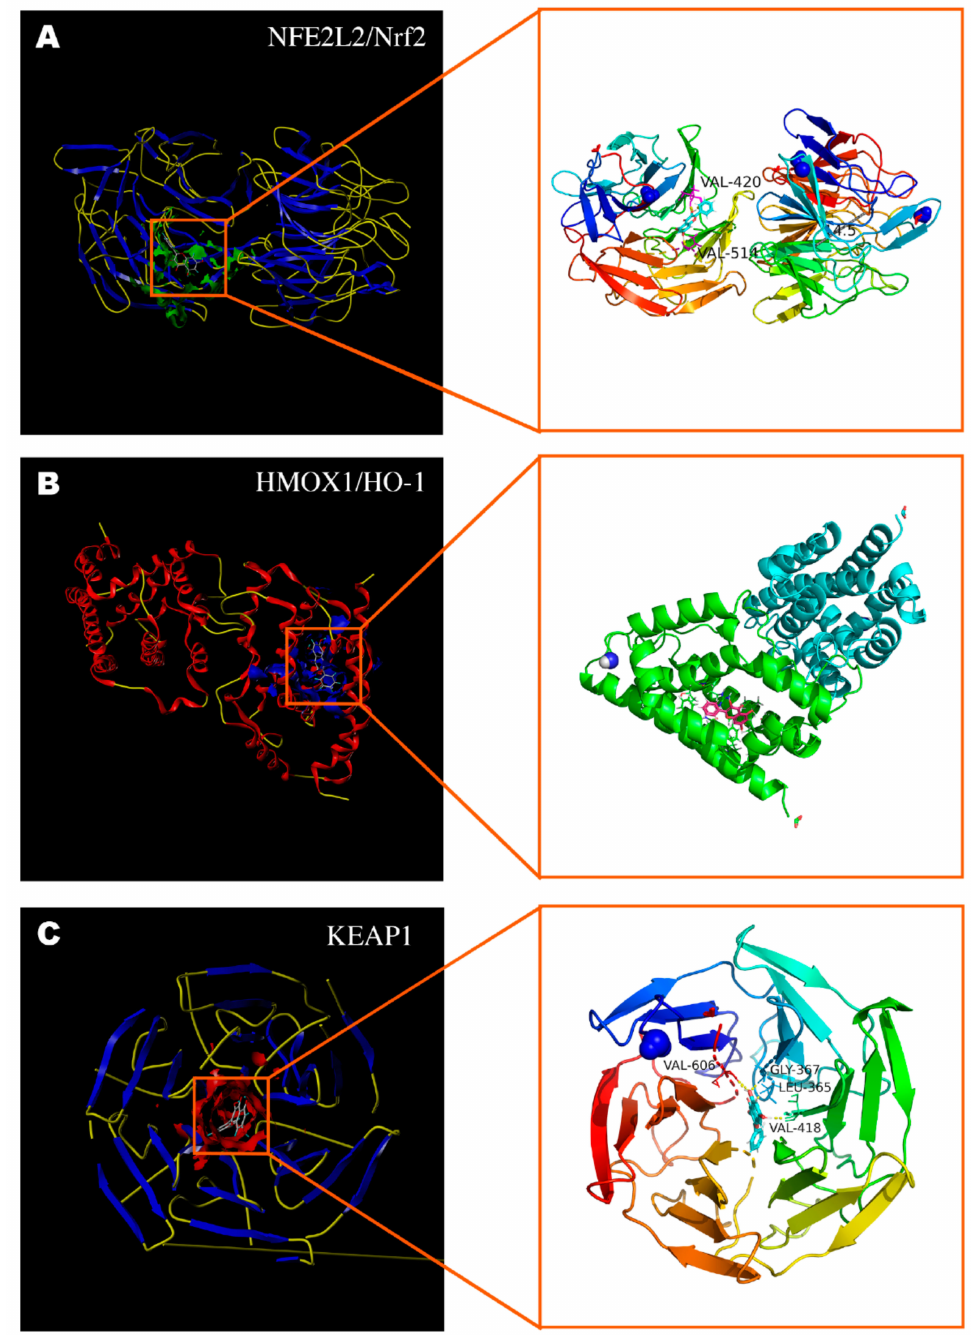
Figure 3. Molecular docking of galangin with core targets. ( A ) Galangin binds to NFE2L2/Nrf2 protein (7K29) via the active residues VAL-420 and VAL-514. ( B ) Galangin binds to HMOX-1/HO- 1 protein (6EHA). ( C ) Galangin binds to Keap1 protein (1ZGK) via the active residues VAL-418, VAL-606, GLY-367, and